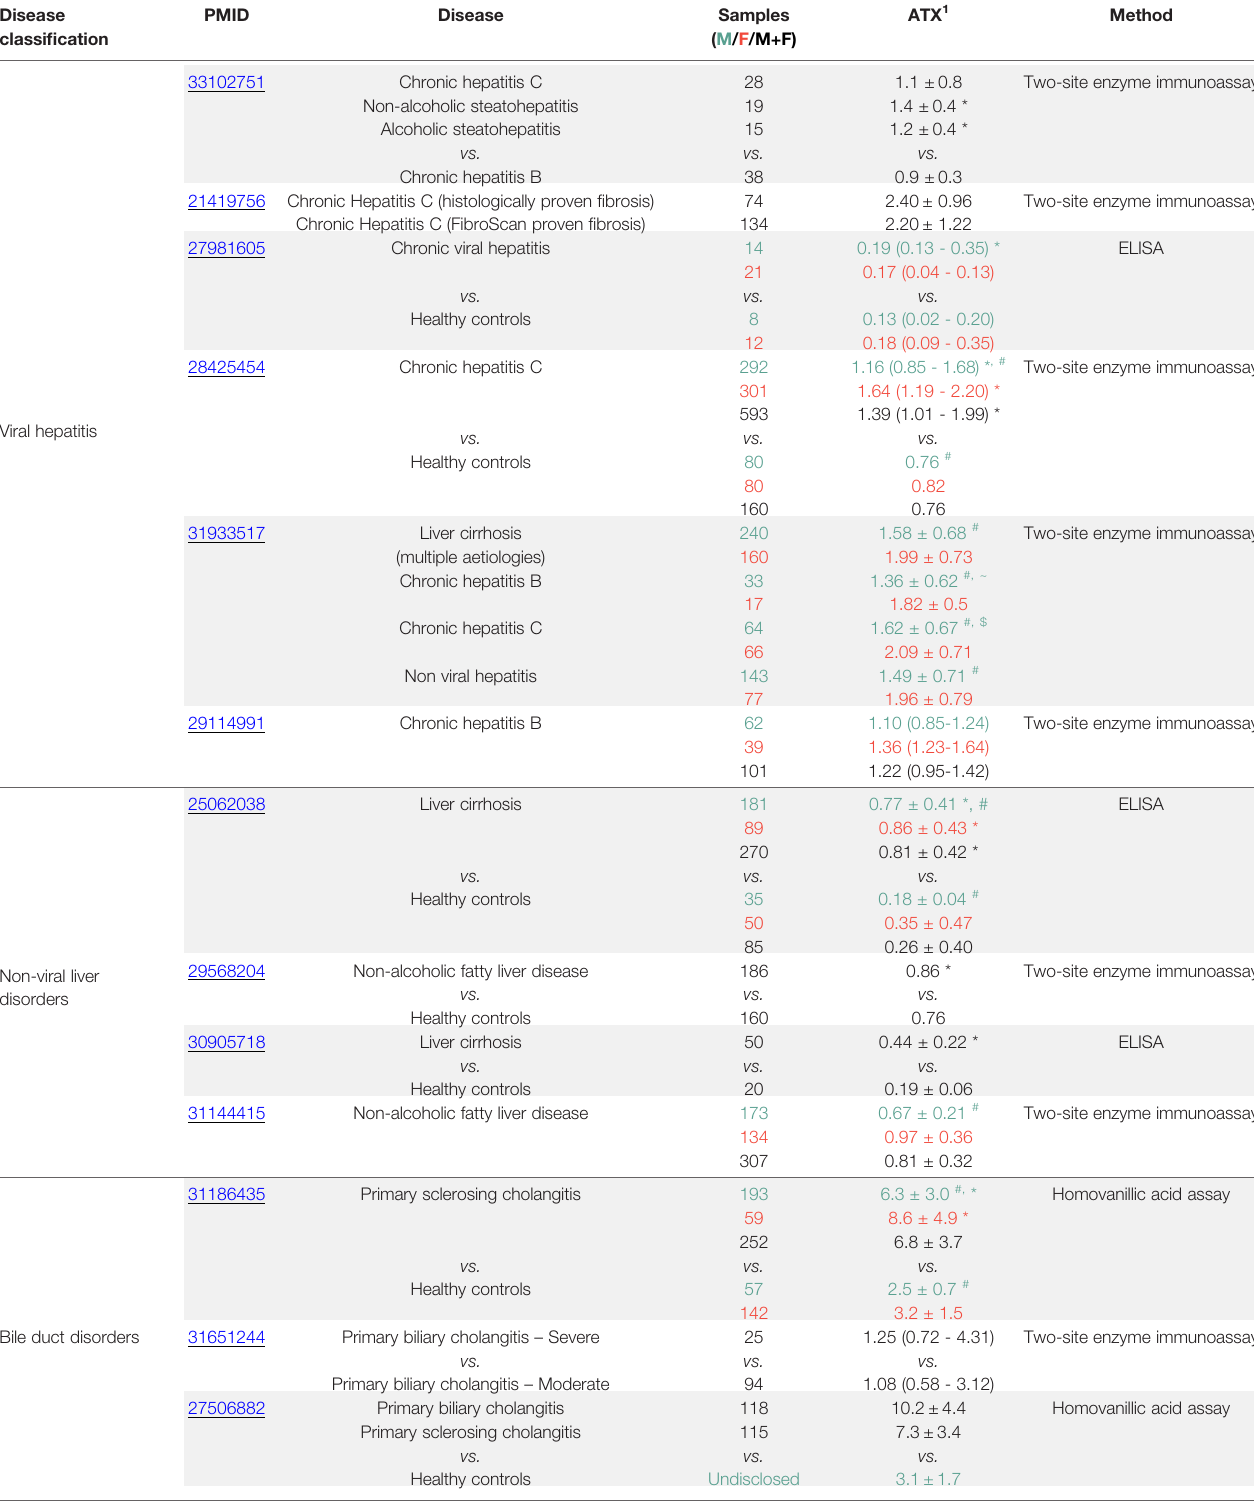
TABLE 1 | Autotaxin serum levels in patients of different in fl ammatory diseases and